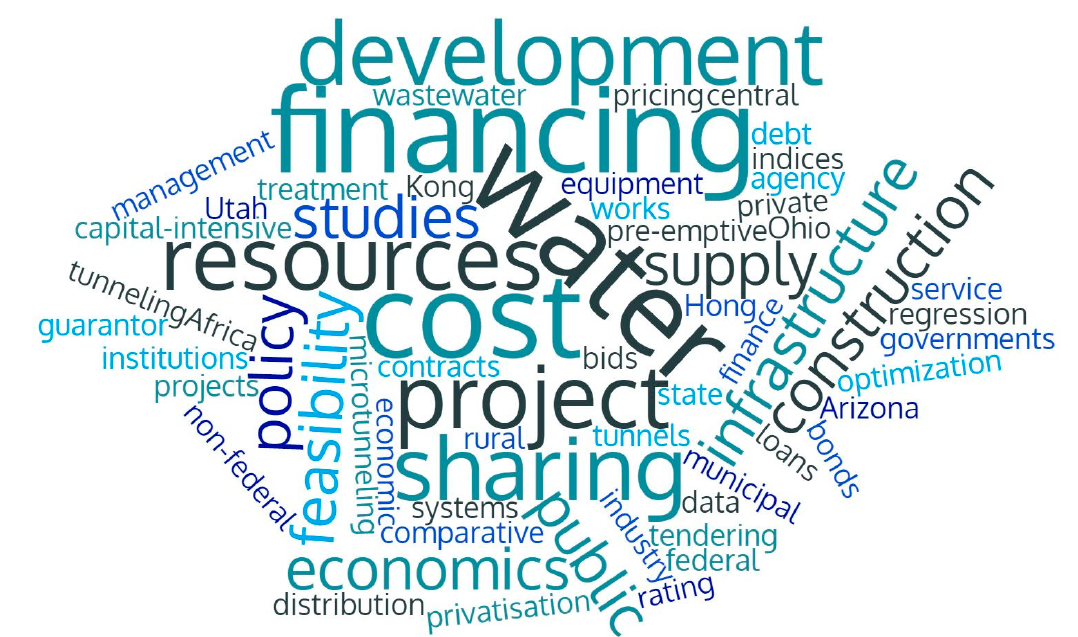
Figure A2. Research topics’ word cloud—1980s.